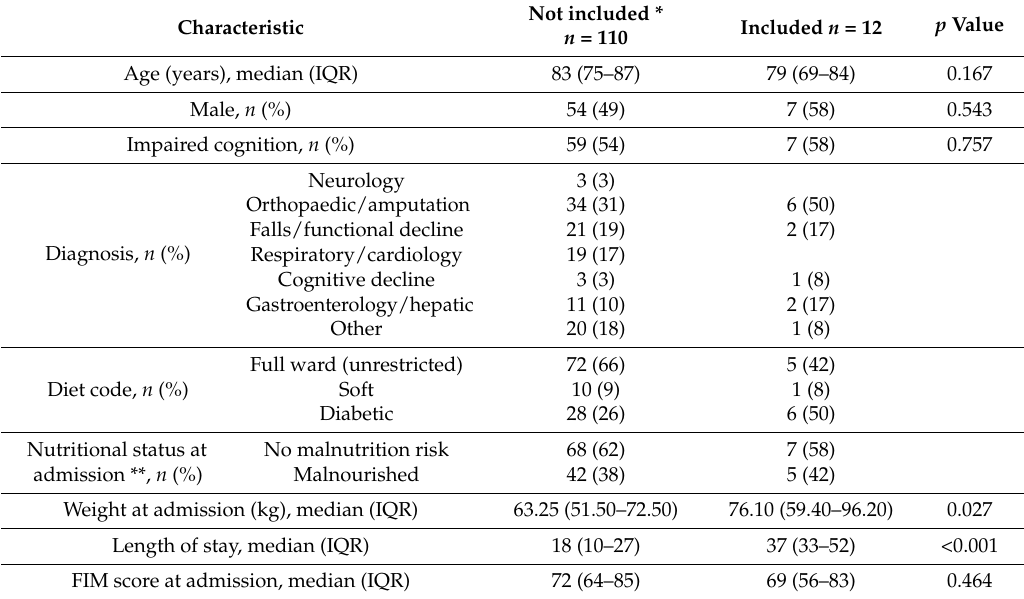
Table A2. Comparison of demographic characteristics of recruited study participants included in analyses and not included in analysis of change in intake between admission, day 14 and day